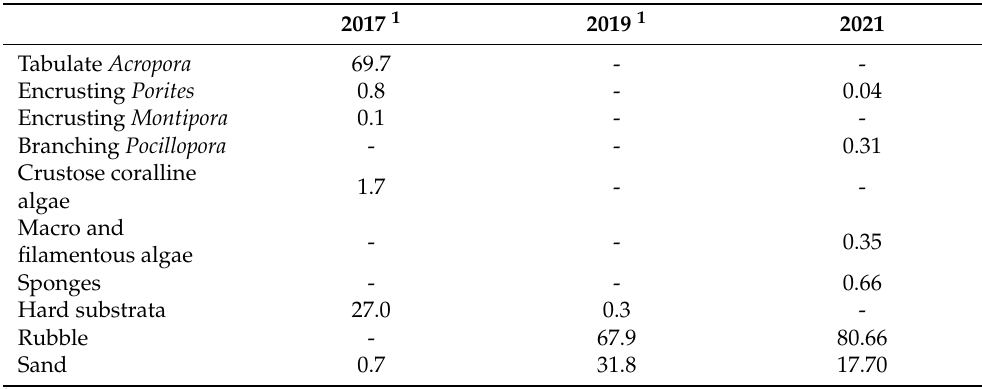
Table 1. Percentage of benthic cover in 2017 (before Walaka), 2019 (nine months after Walaka) and 2021 (three years after Walaka), with “-” denoting no